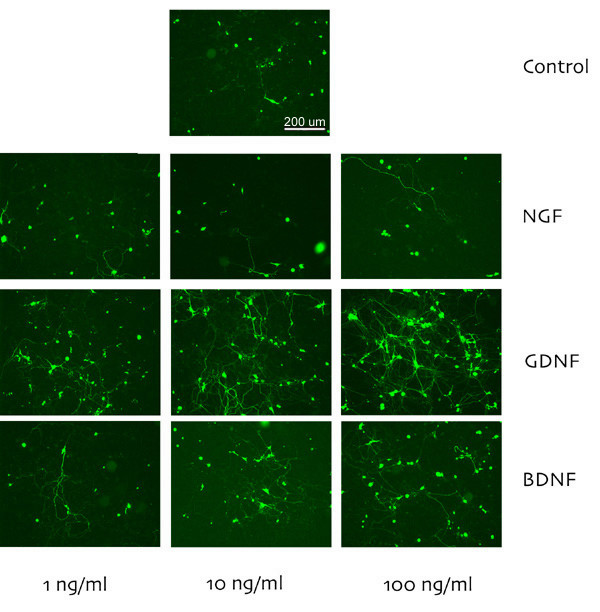
Representative 20X photomicrographs of growth factor-treated TG neurons. TG cultures were fixed and labeled for NF-H-immunoreactivity (green), and the 20X photomicrographs depicted here are representative of the 20 images taken per slide for each condition for neuron counting. The upper frame shows the no growth factor treated control with corresponding growth factor treatments shown for BDNF, GDNF and NGF at 1, 10 and 100 ng/ml concentrations.